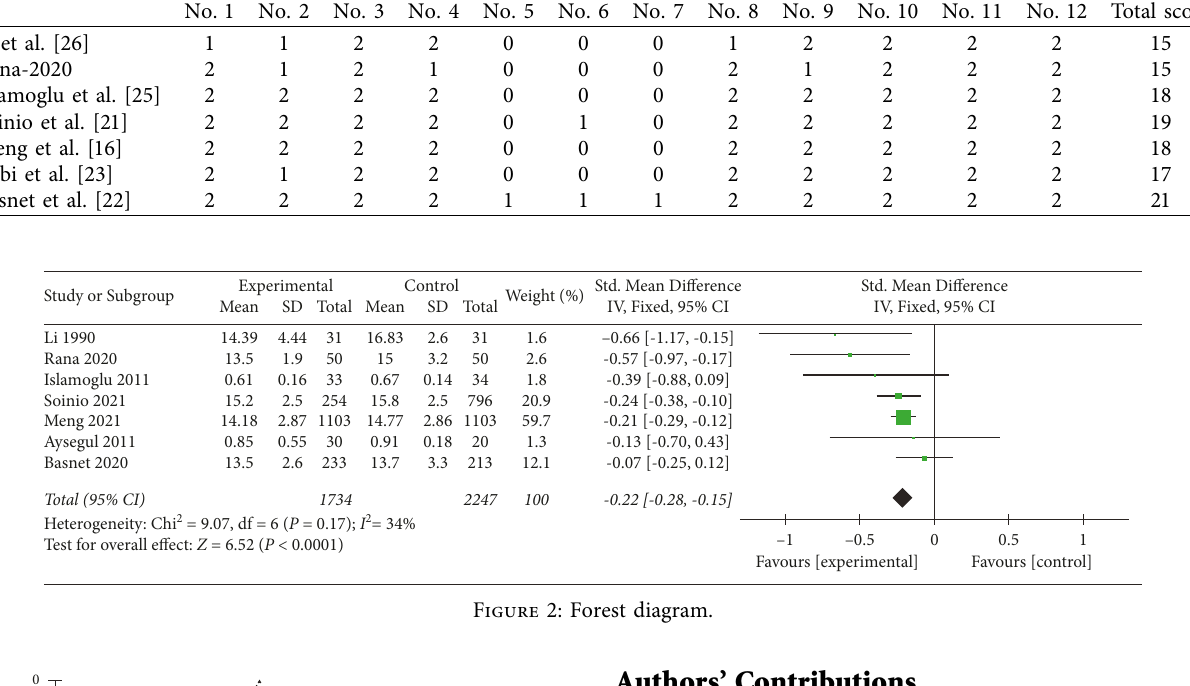
Table 2: Quality assessment